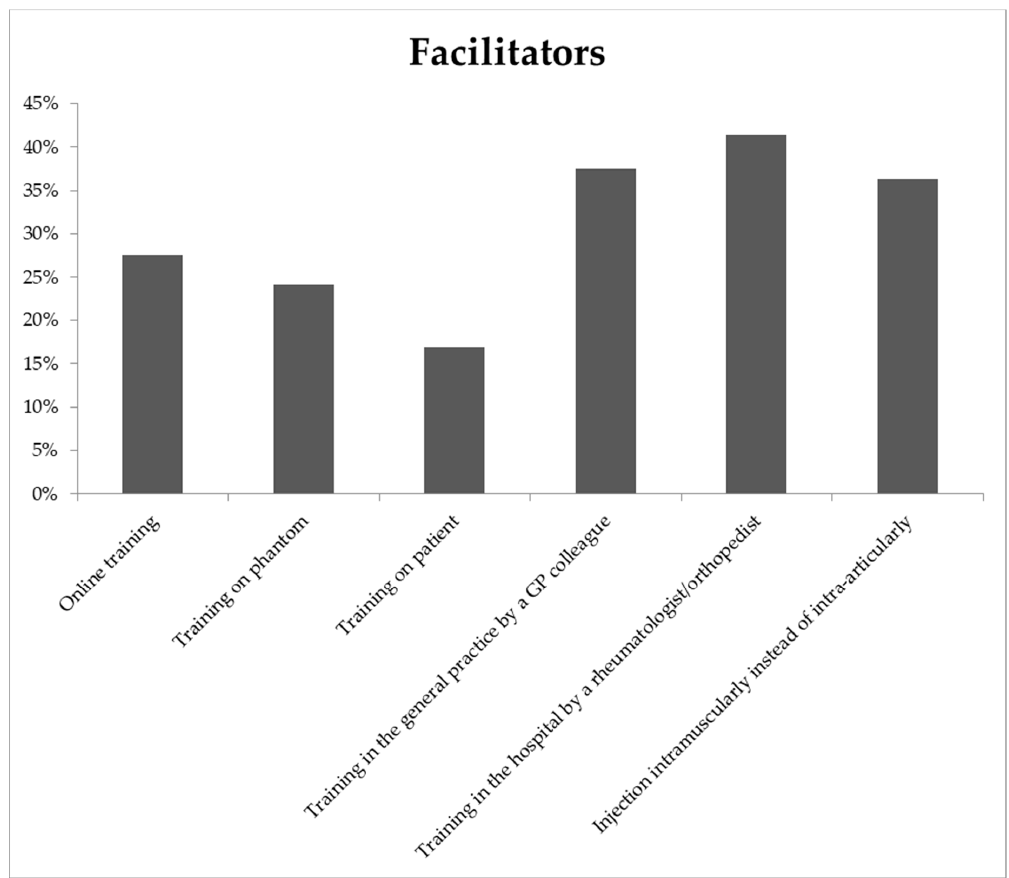
Figure 2. Percentage of GPs reporting selected facilitators to performing musculoskeletal injections (N = 355).